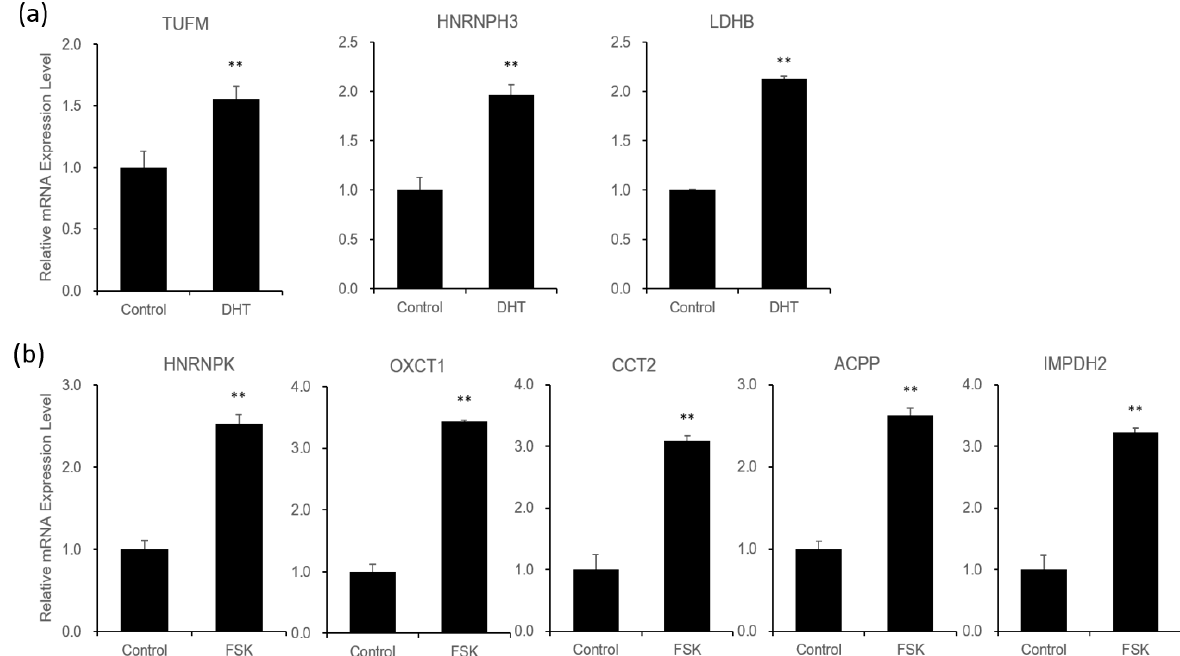
Figure 3. Relative mRNA expression levels of identified proteins that are significantly induced by androgen and PKA signaling pathways. Changes in the mRNA level of proteins significantly modulated by DHT ( a ) or FSK ( b ), as determined by qRT-PCR analysis. All data obtained from the means ± SD of three independent experiments are presented as fold changes (** p < 0.01).